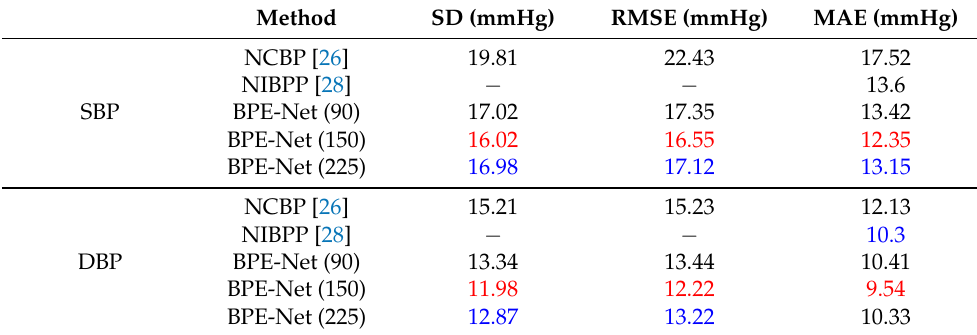
Table 5. Results of BP estimations in the MMSE-HR